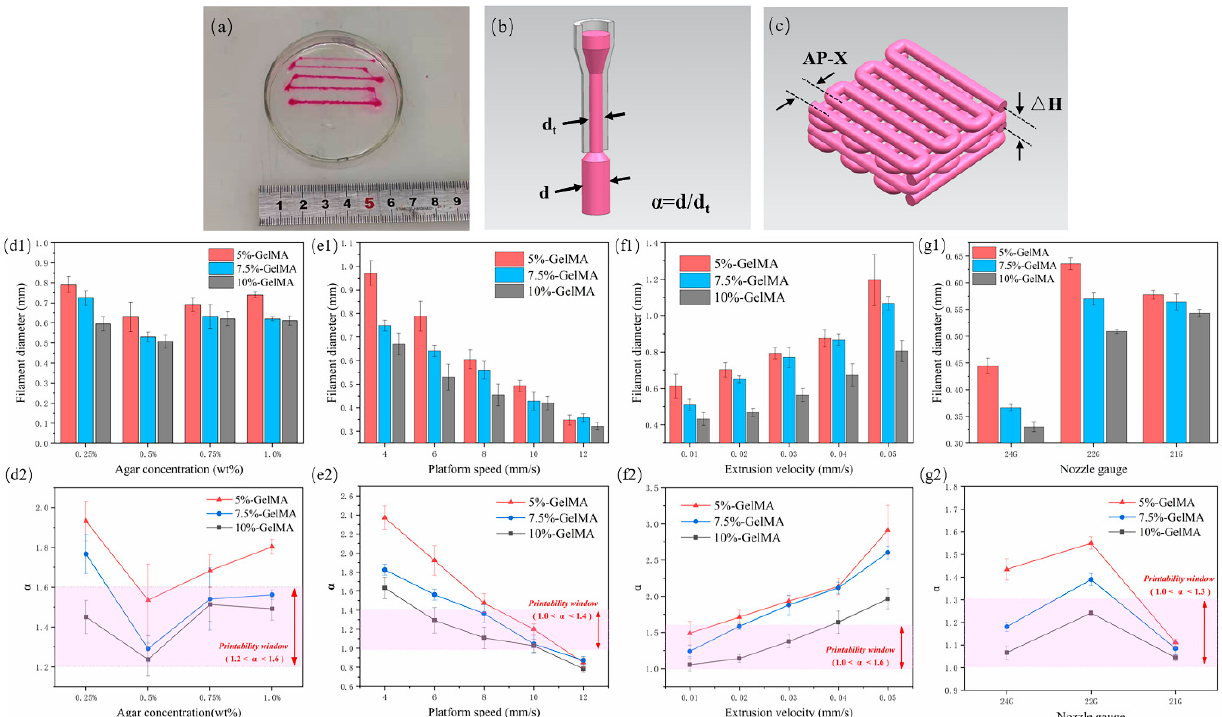
Figure 2. GelMA extrusion performance test results. ( a ) Actual graph of GelMA wire under different extrusion speeds; ( b ) schematic diagram of α ; ( c ) schematic diagram of the scaffold layer height and wire spacing; ( d1 – g1 ) measurement results of the wire diameter for different agarose concentrations, platform moving speed, extrusion speed, and nozzle size, respectively, ( d2 – g2 ) corresponding α values and printability window.